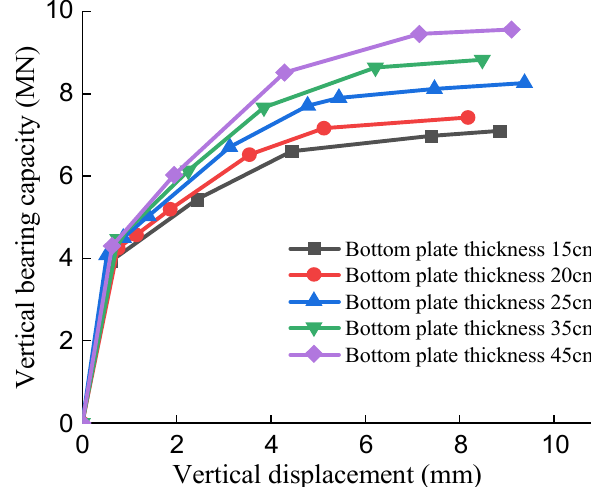
Figure 18. Comparison of different base plate thicknesses.